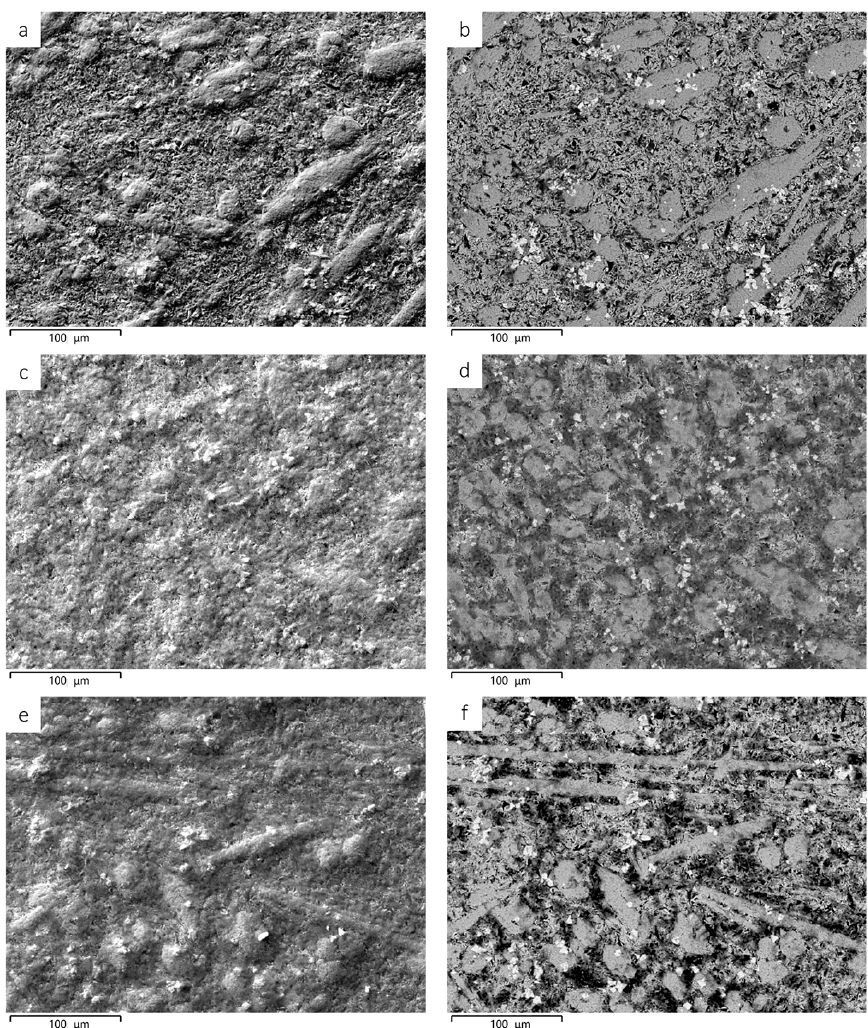
Figure 14. SEI-BSE images of the center of the crater: ( a ), ( b ) SEI-BSE images of the as-received hardfacing after 30 min of erosion; ( c ), ( d ) SEI-BSE images of the heat-treated hardfacing after 30 min of erosion; ( e ), ( f ) SEI-BSE images of the heat-treated hardfacing after 60 min of erosion.